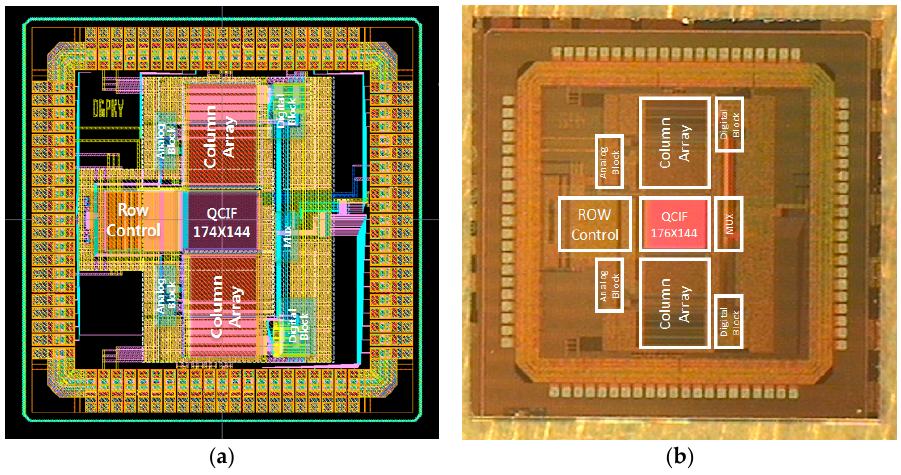
( b ) Figure 8. Simulation results showing ( a ) row control signals and ( b ) pixel output voltage (V IN ) for the input of column ADC array with different resolutions. 4.2. Measurement Results Figure 9 shows the entire layout and microphotograph of the CIS fabricated with a 0.18 μ m